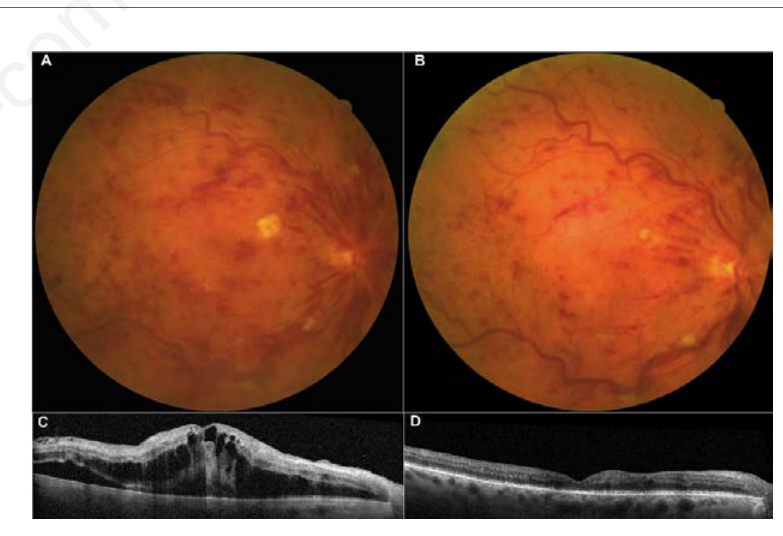
Figure 1. Magnetic resonance images acquired 4 days after the onset of paraplegia. T2- weighted sagittal (A) and axial (B) images show hyperintensity at the T12-L1 level in the form an anteromedial spot. No other spinal cord lesions were detected.